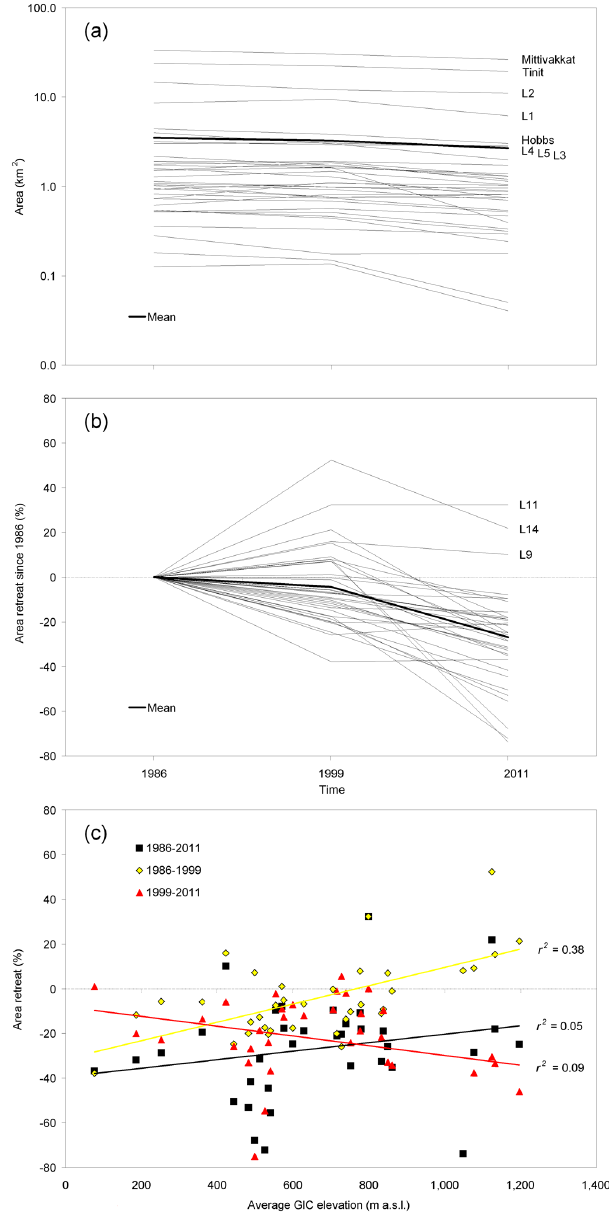
Fig. 10. (a) Land-terminating GIC area for the 35 observed GIC (Mittivakkat, Hobbs, Tinit, and L1–L32 glaciers) for 1986, 1999, and 2011 (the listed glaciers are illustrated as an example in Fig. 11); (b) relative GIC area change since 1986 (the named glaciers are the ones with area increase); and (c) relative GIC area change in relation to variations in mean elevation GIC height